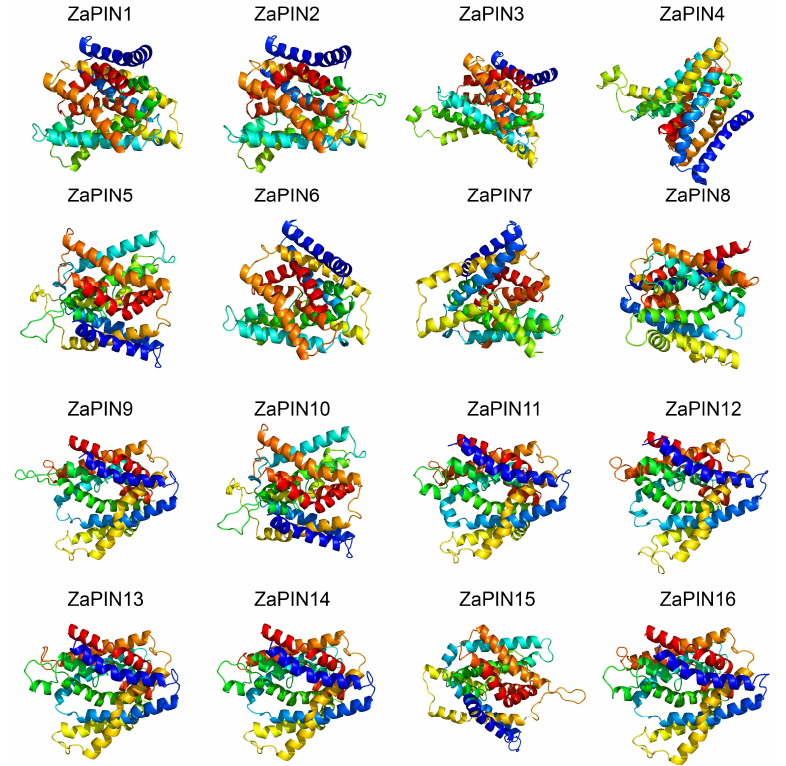
Figure 1. Predicted 3D structure of ZaPINs.